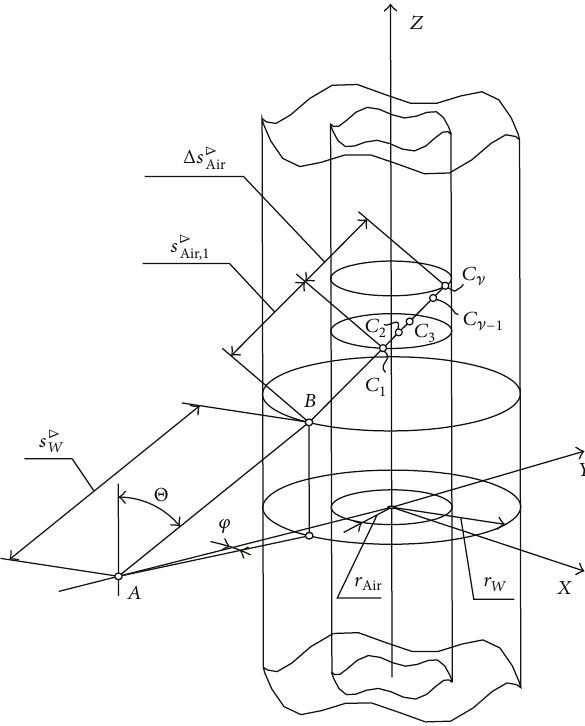
Figure 2: Explanatory draft of the calculations of fluence rate in point 𝐴 .